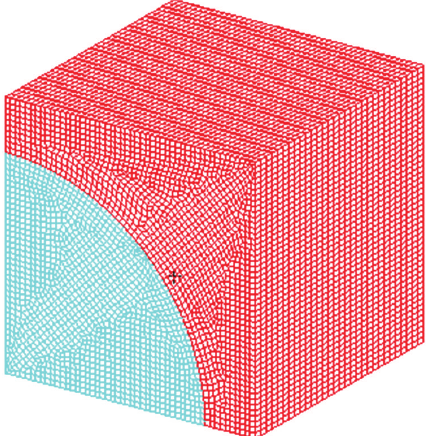
Table 4: Predicted maximum 𝜀 compression and pure shear